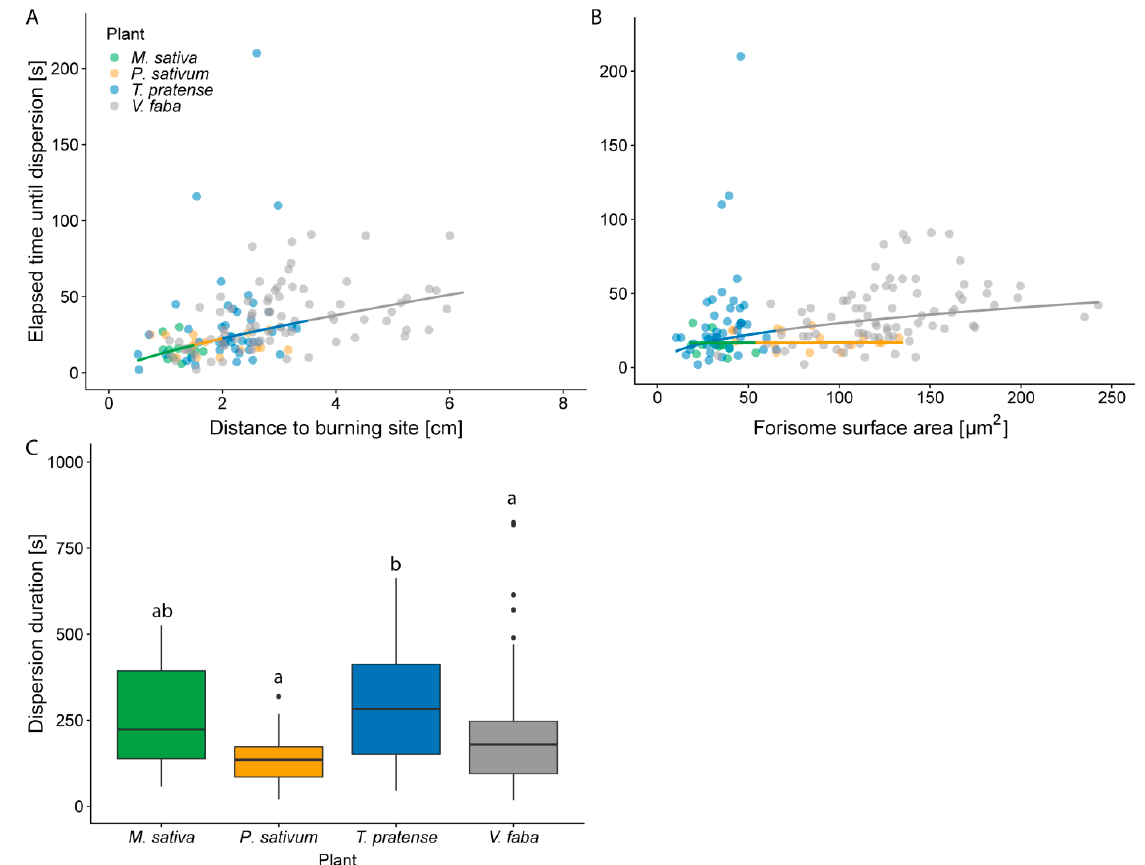
Figure 3. Influence of different parameters on the time lapse between heat stimulation and complete dispersion and on the dispersion time length. Only forisomes from experiments on the target leaflet were analysed. Both, ( A ) distance to the burning site and ( B ) the interaction of forisome surface area ( A F ) and species ( B ) have an effect on the time lapse between stimulus application and forisome dispersion. For easier visualization the results are shown in separate graphs. ( C ) Boxplot of the duration of dispersion associated with the species. Depicted are the median and the first and third percentile. Different letters indicate statistically significant differences. Statistical values are shown in Table S3. Replicates from different species (replicates for the time until dispersion; replicates for the duration of dispersion) are presented in different colours: green— M. sativa ( n = 11; n = 11), orange— P. sativum ( n = 16; n = 16), blue— T. pratense ( n = 43; n = 36), and grey— V. faba ( n = 77; n = 75).